Question: Sum up the contents of this chart in one sentence.
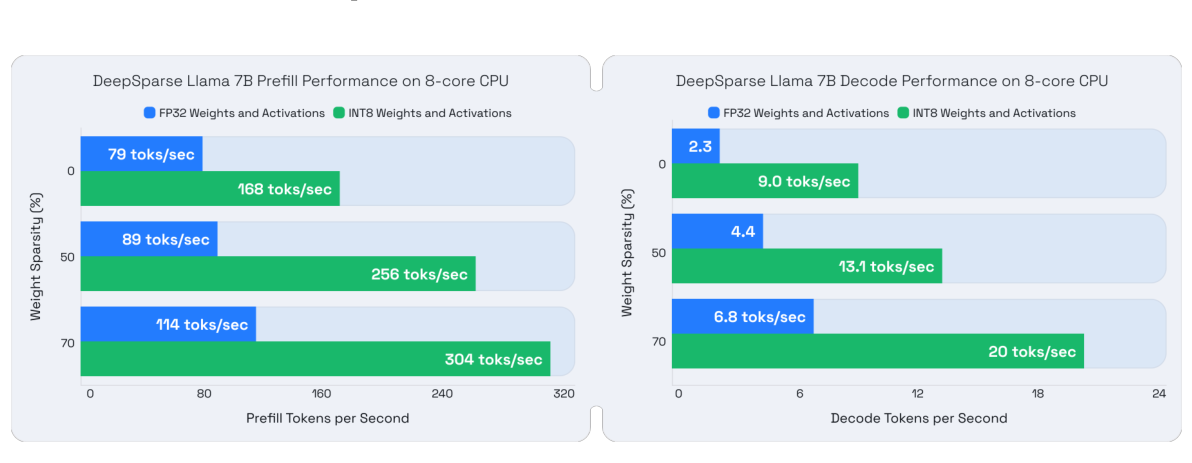
Answer: visually demonstrates the significant performance gains achieved through our combination of sparsity and quantization. Compared to baseline FP32 models, we observed the following improvements on CPUs: